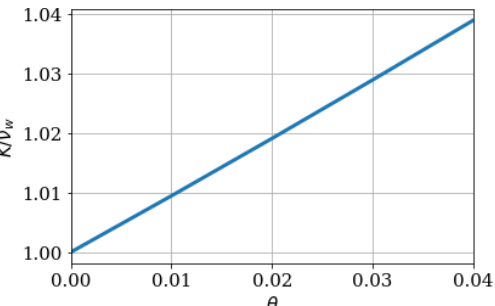
Figure 1. Relative effective momentum dissipation K/ν w , as a function of volumetric ratio of air to water (cid:50) , using Eq. (10). As- sumed here, the ratio is N ν := ν w /ν a = 1 / 15. The range or (cid:50) has been limited to that applicable to oceanic conditions (over the whole range, the relative effective momentum dissipation is a monotoni- cally increasing